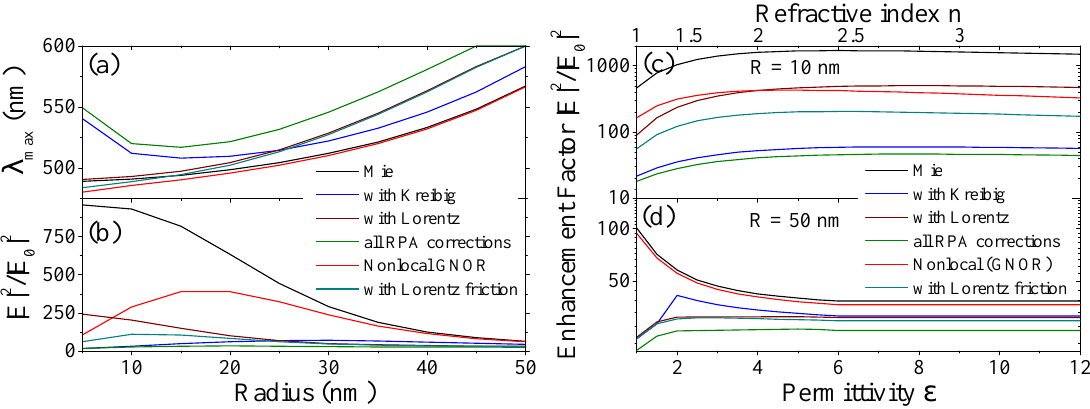
Figure 4. Maximum enhancement factor EF = | E | 2 / | E 0 | 2 at the particle surface for gold. Dependence of ( a ) the maximum EF and ( b ) its wavelength position for the different quantum corrections on the particle radius in water. ( c ), ( d ) The same as a function of the permittivity (cid:101) 0 of the surrounding medium for nanospheres of ( c ) R = 10nm and ( d ) R =